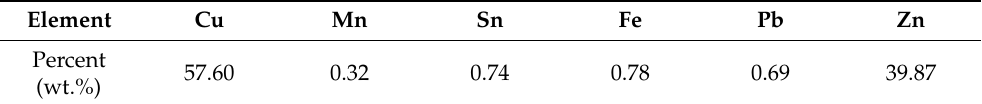
Table 2. The chemical composition of manganese bronze used in this work.